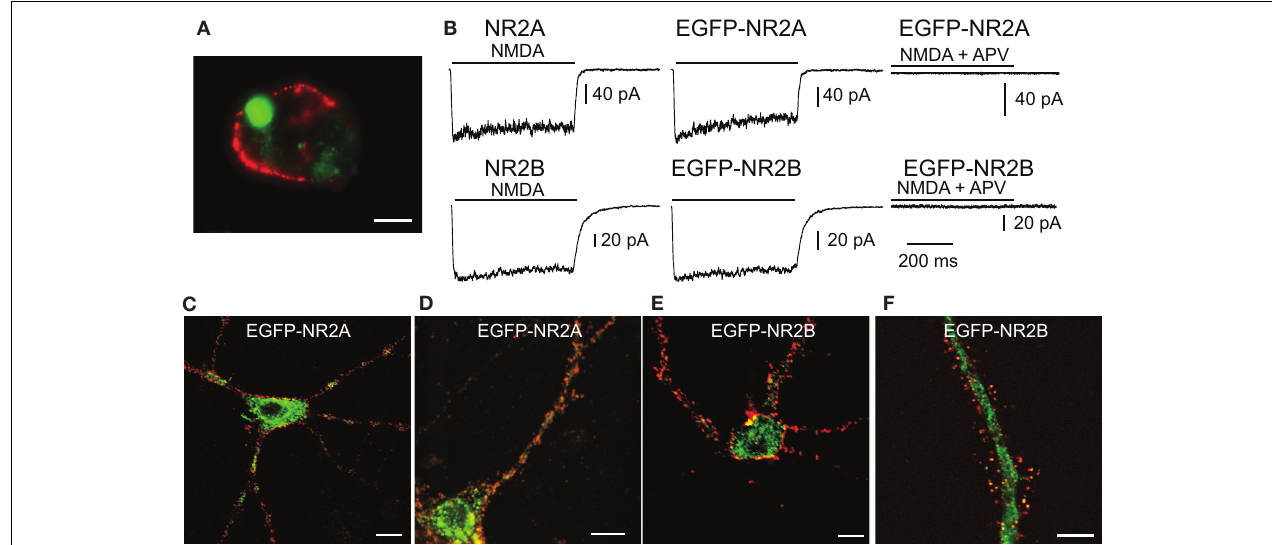
FIGURE 1 | EGFP-tagged NMDARs are transported to the cell membrane and are functional. (A) HEK293 cells were co-transfected with NR1 and EGFP-tagged NR2A or NR2B. The surface staining of extracellular EGFP (red) under non- permeabilizing conditions shows tagged NMDA receptors transported to the cell membrane. Scale bar: 5 µm. (B) Application of 100 µM NMDA and 10 µM glycine (500 ms) induced an inward current in HEK293 cells co-transfected with NR1 and EGFP-NR2A or EGFP-NR2B. These currents could be blocked with the NMDAR